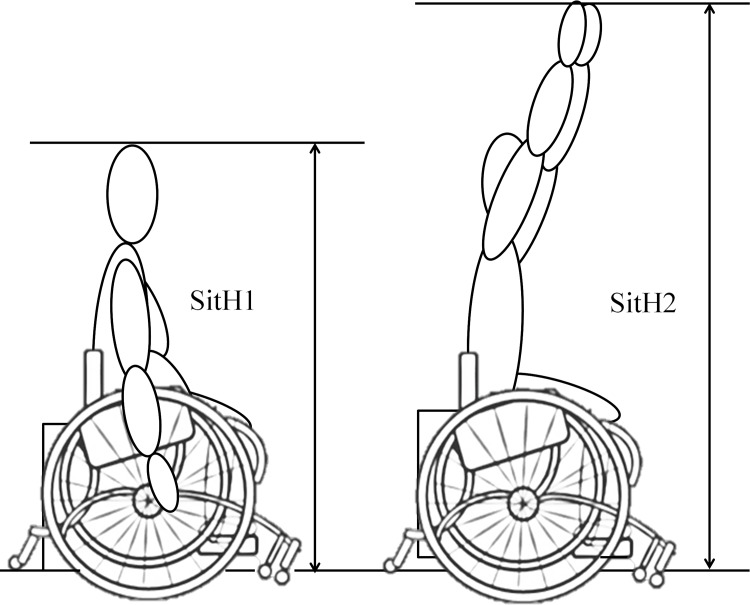
The two measurements of sitting height.SitH1: the vertical distance from the vertex of the head to floor; SitH2: the vertical grip reach from a seated position, was measured as the maximal distance from the tip of the dactylion III at the maximum to the floor, with the upper arms extended overhead as much as possible.